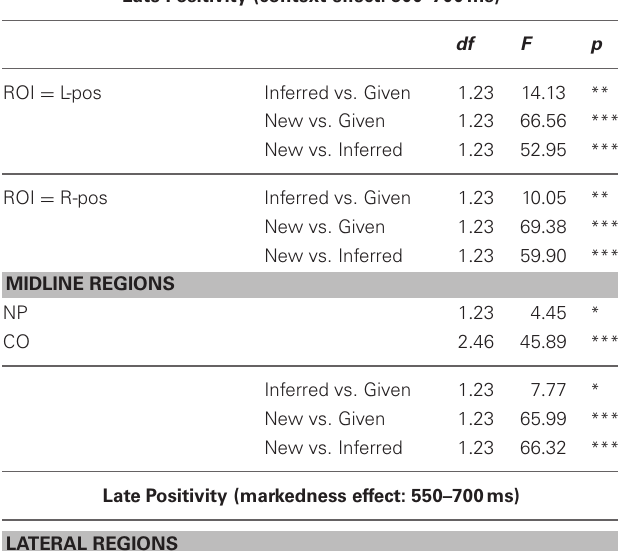
Table 2 | Analysis of variance (ANOVAs) of the mean ERP amplitudes in Experiment